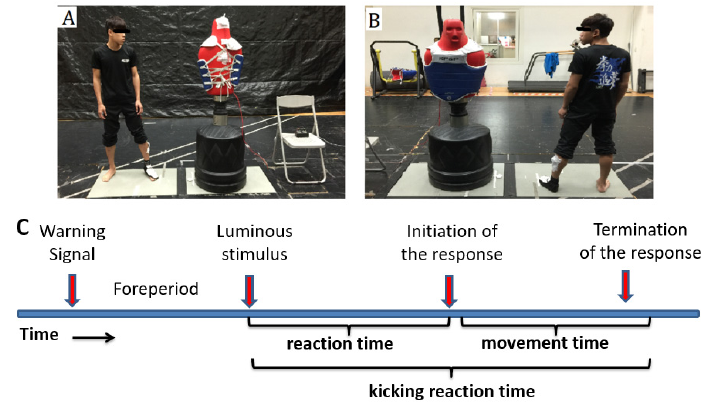
Figure 3. The kicking reaction time test venue layout ( A and B ) and the response time theory ( C